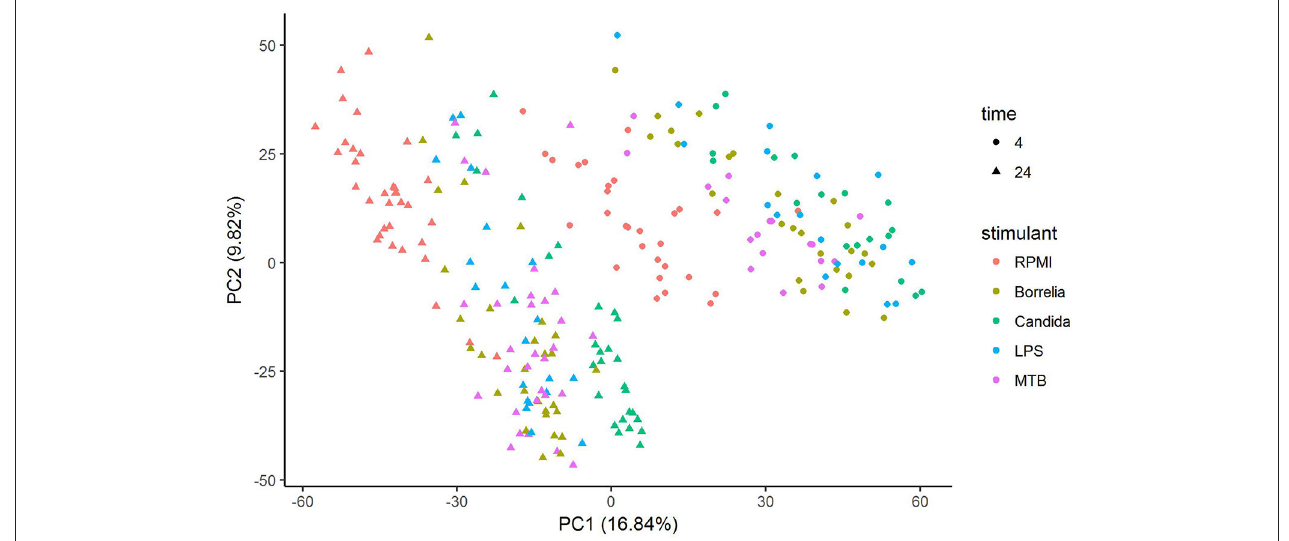
FIGURE 1 | Principal component analysis of gene expression of human PBMCs stimulated by Candida , Borrelia , LPS and MTB for 4 and 24 h.